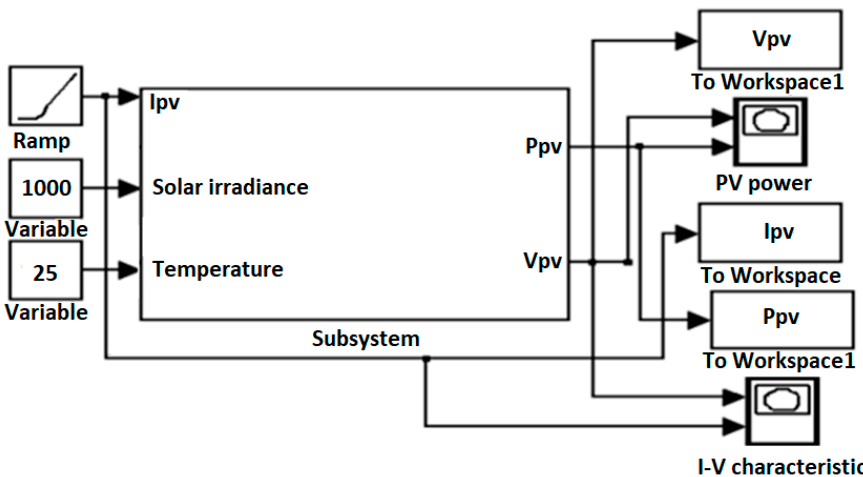
Figure 4. PV generator test block diagram implemented in MATLAB/Simulink.